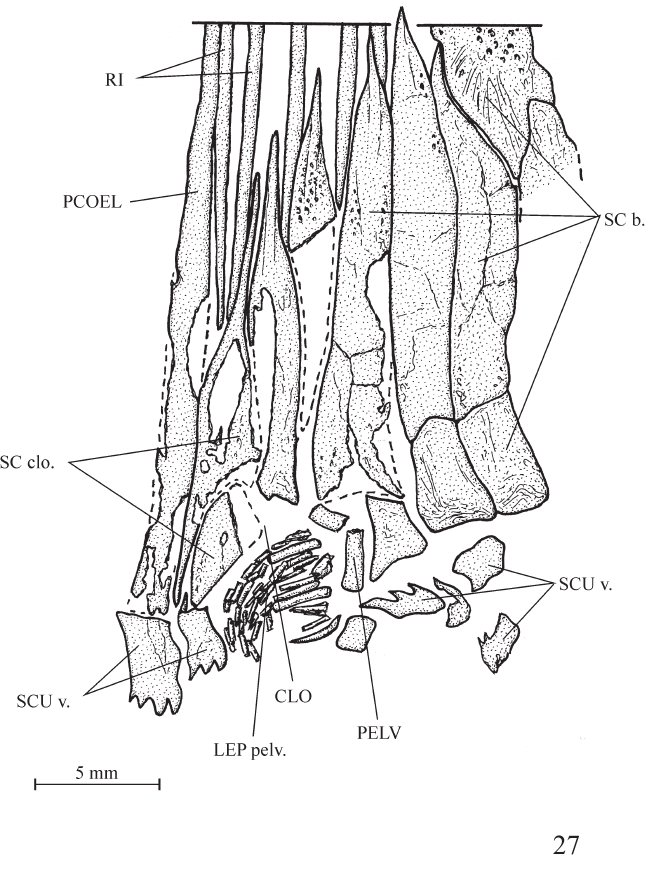
Fig. 26. Akromystax tilmachiton Poyato-Ariza & Wenz, 2005. Pelvic girdle and scales from the cloacal region of sample